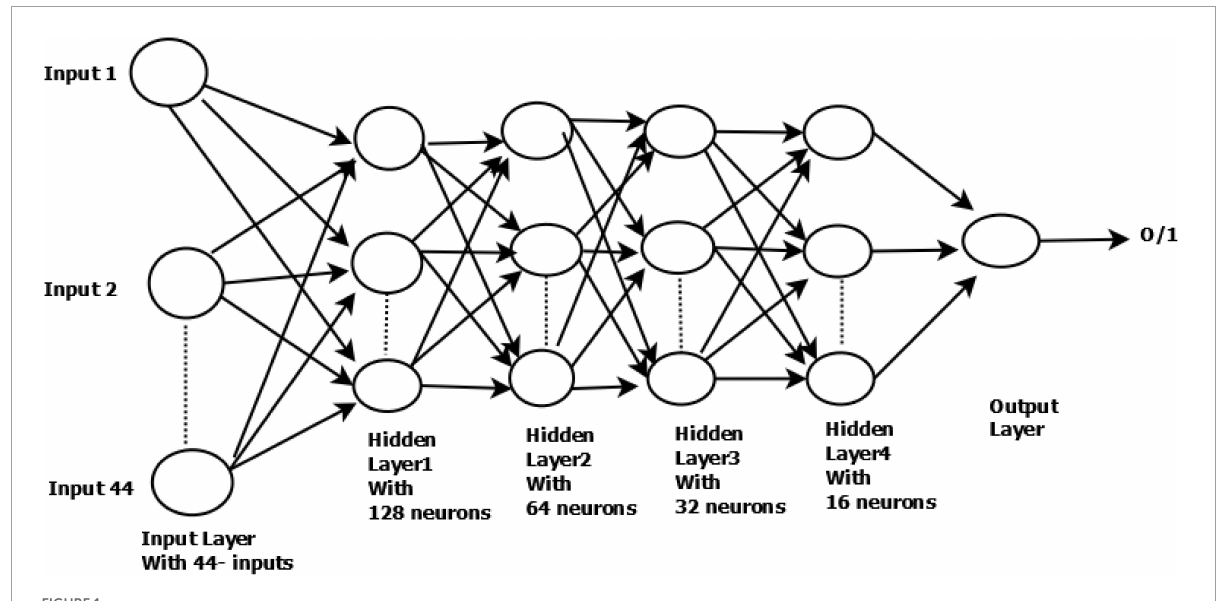
FIGURE1 Structure of DNN used in our research work.